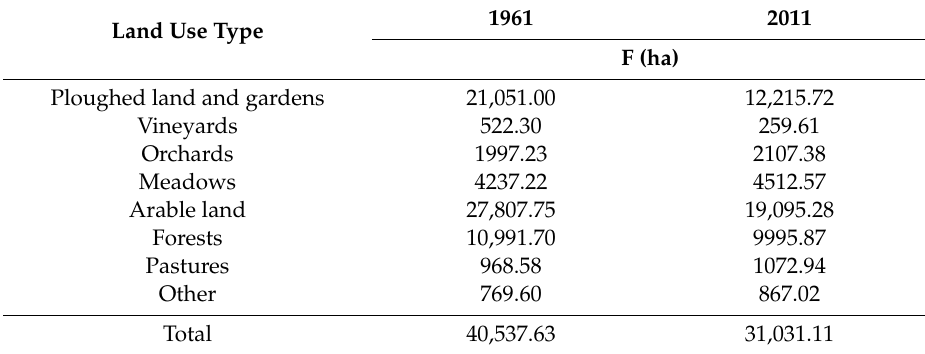
Table 3. Structure of land use in rural settlements in the territory of the Jablanica River Basin in 1961 and